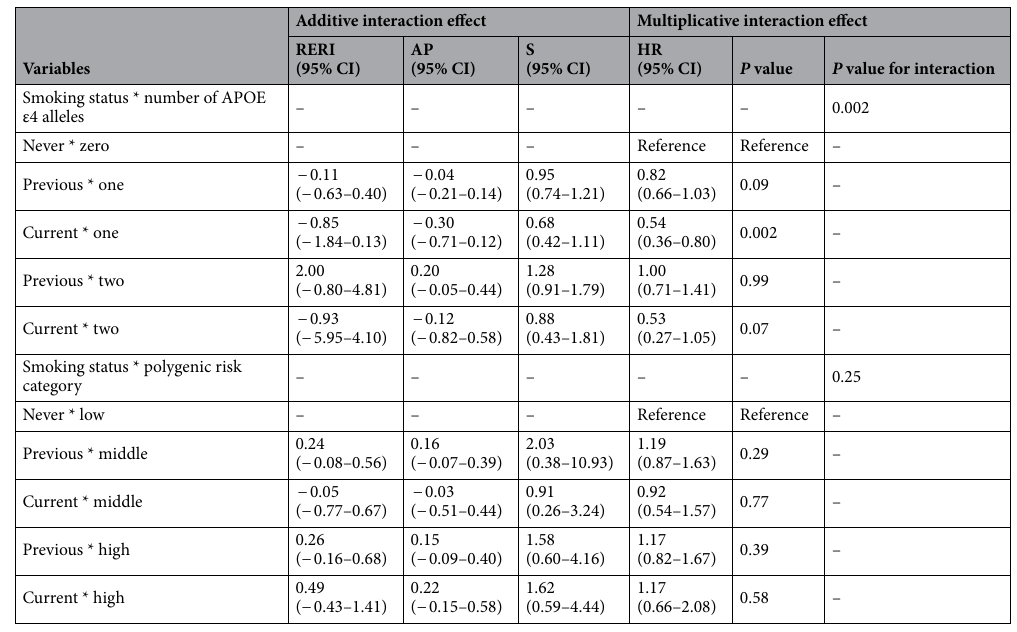
Table 4. Interactions between smoking status and genetic predisposition on dementia risk. HR, hazard ratio; CI: confidence interval; RERI, relative excess risk due to interaction; AP, attributable proportion; S, synergy index; RERI = 0; AP = 0; S = 1: no interaction; RERI > 0; AP > 0; S > 1: positive interaction; RERI < 0; AP < 0; S < 1: negative interaction. Dash “–”: not applicable. P value for interaction: results from likelihood ratio test to compare the reduced model excluding interaction term with the full model including the term. All analyses were adjusted for age, sex, educational attainment, deprivation quantile, BMI, parental dementia status, and 5 principal components of